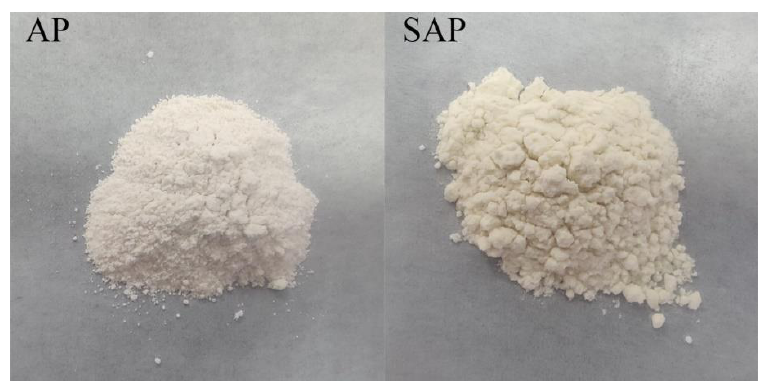
Figure 5. Photograph of AP and SAP.